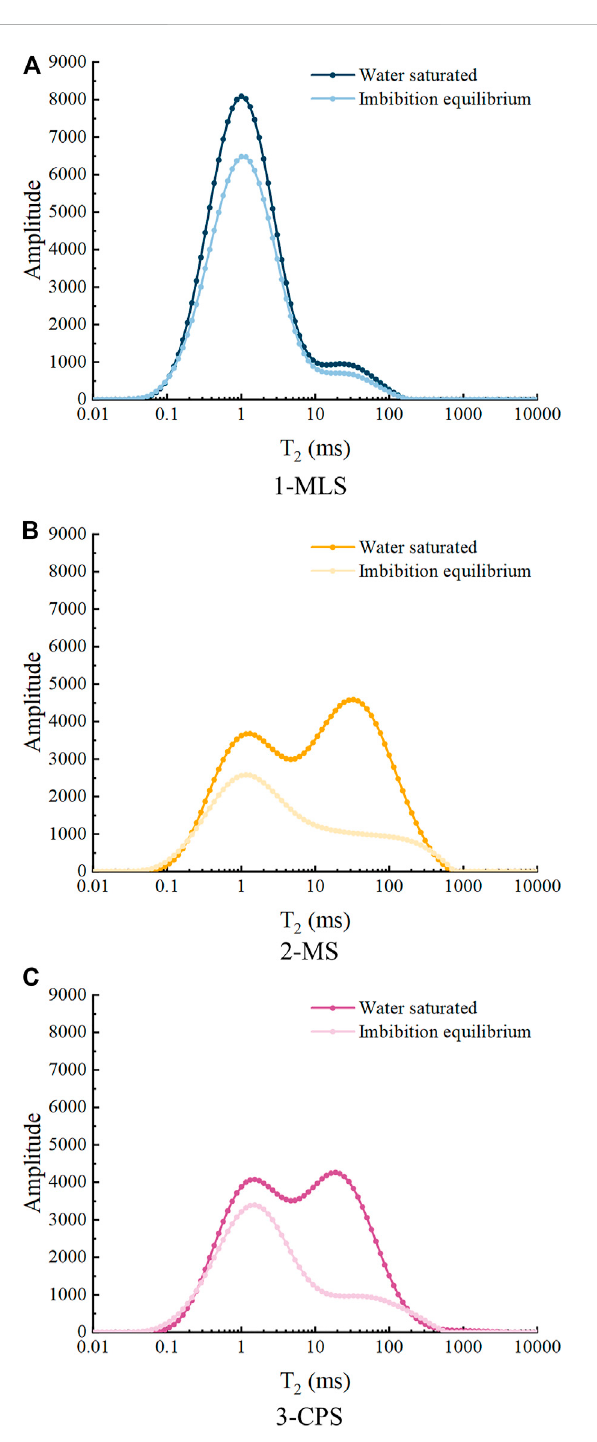
FIGURE 7 T 2 spectrumsofdifferentcoreschangedwithtime: (A) MLSsample; (B) MS sample; (C) CPS sample.